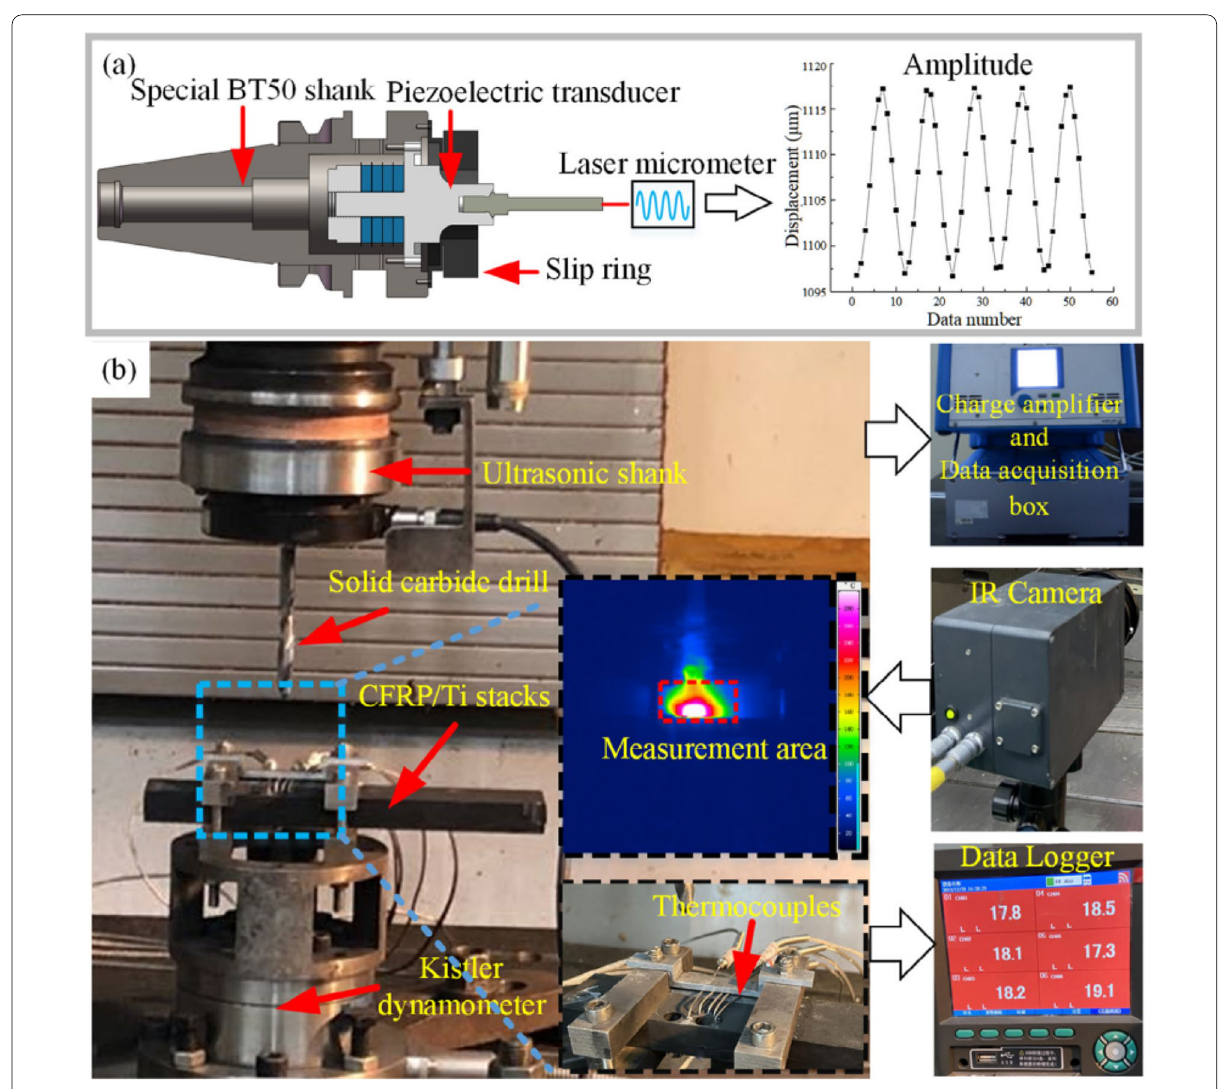
Figure 24 The system of UAD: a The details of ultrasonic shank and b Experimental setup